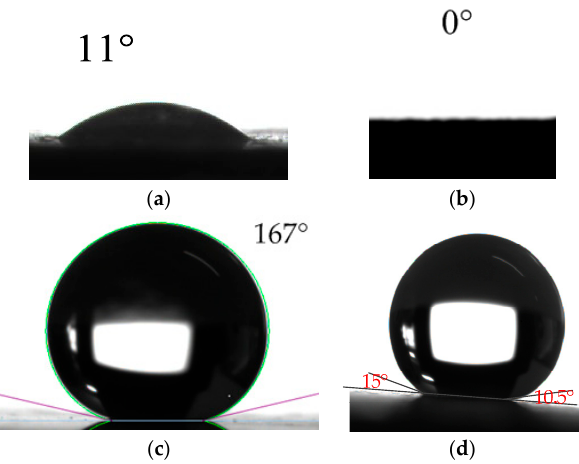
Figure 4. Optical photo of water droplets on surfaces with different morphology: ( a ) untreated sheet surface; ( b ) sheet surface after oxidation; and ( c ) superhydrophobic sheet surface; ( d ) Snapshot photograph of the advancing CA and receding CA of the superhydrophobic sheet surface.